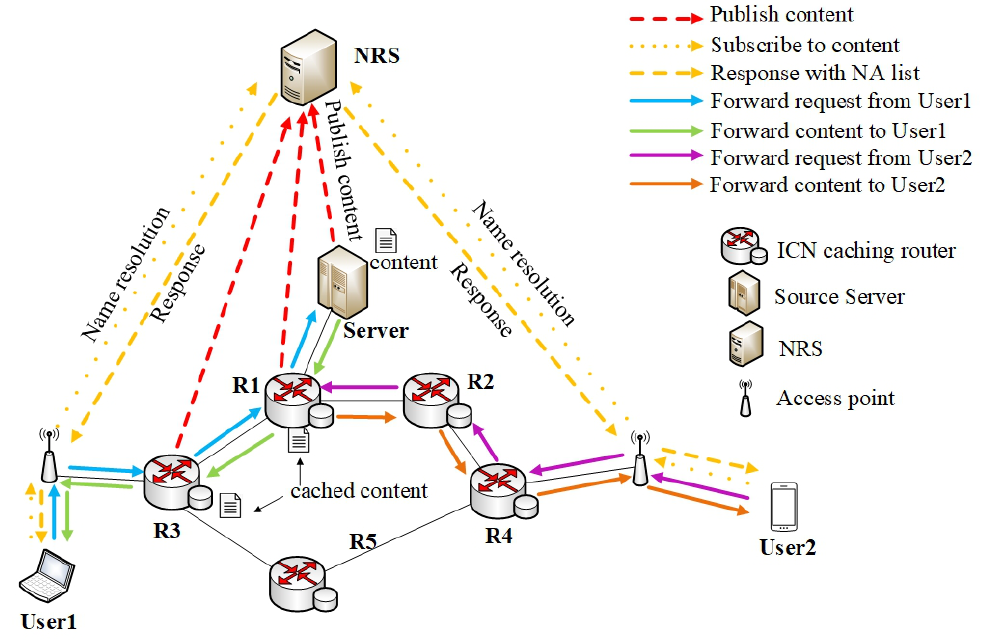
Figure 1. An ICN caching scenario with an